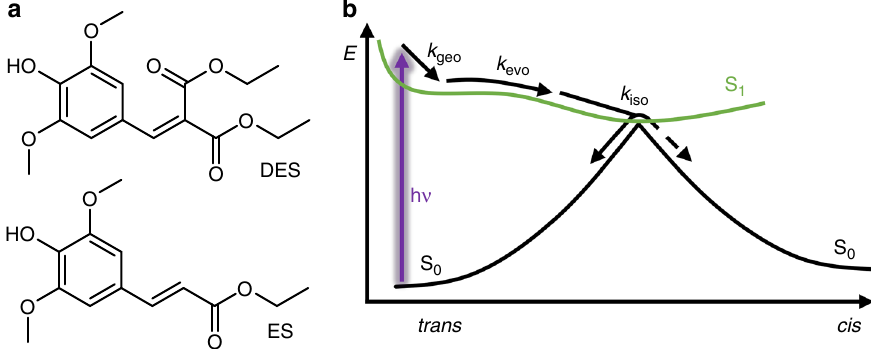
Fig. 1 Sinapate structures and photoisomerization scheme. a The geometric structures of diethyl sinapate (DES) and ethyl sinapate (ES), demonstrating the symmetrical functionalization of DES compared to its precursor ES. b Schematic illustrating the dynamical processes involved in the photoisomerization of ES. Following photoexcitation with a UV photon (represented by the purple arrow), to the fi rst electronically excited (S 1 ) state (green curve), trans -ES undergoes three processes during its subsequent relaxation to the electronic ground (S 0 ) state (black curve). Each process is indicated by a labelled arrow: k k geo represents the rate of the geometry rearrangement; evo is the rate of evolution in the electronic excited state, such as vibrational cooling, along with solvent rearrangement; and k iso is the rate for the photoisomerization. At the S 1 /S 0 conical intersection, where the green and black curves meet, there are two possible pathways: relaxation to the S 0 state of the trans - or cis -ES species, represented by the solid black and dashed black arrows